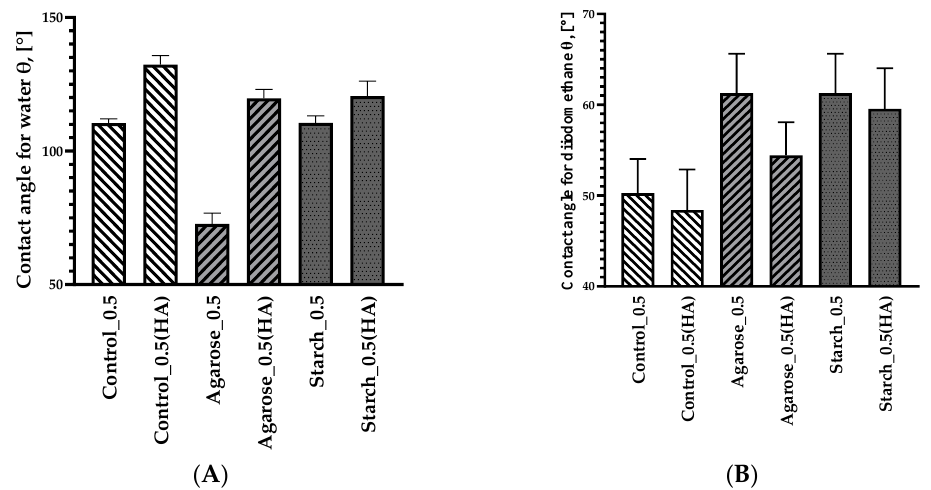
Figure 10. Contact angles of water ( A ) and diiodomethane ( B ) on the surfaces of selected blends (0.5M NaOH) after thermo-oxidative aging. (0.5M NaOH) after thermo-oxidative